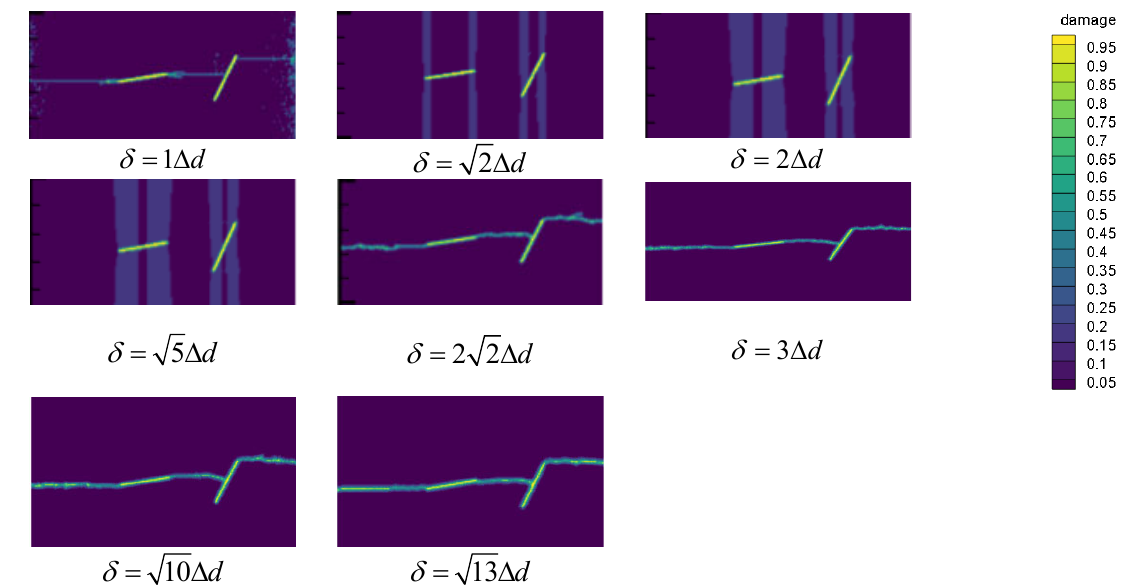
Figure 7. Crack path with different neighborhoods.